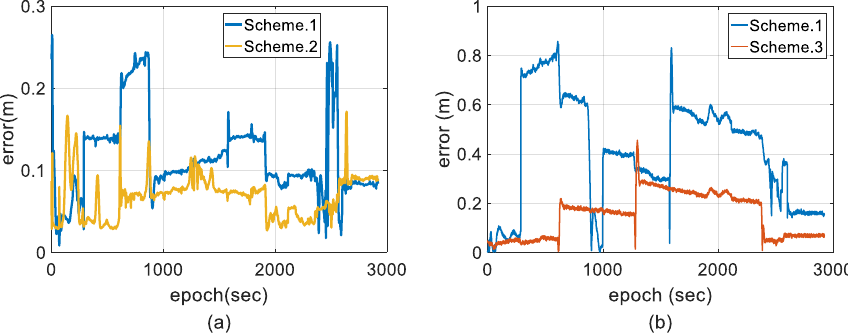
Figure 11. Comparisons of position error. ( a ) Horizontal; and ( b ) vertical.